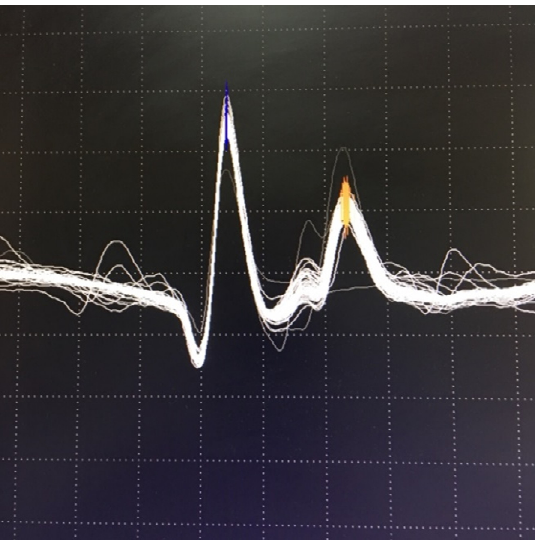
Figure 7. Normal volitional jitter in frontalis muscle: 22 microseconds, grid 0.1 mv by 0.3 msec.